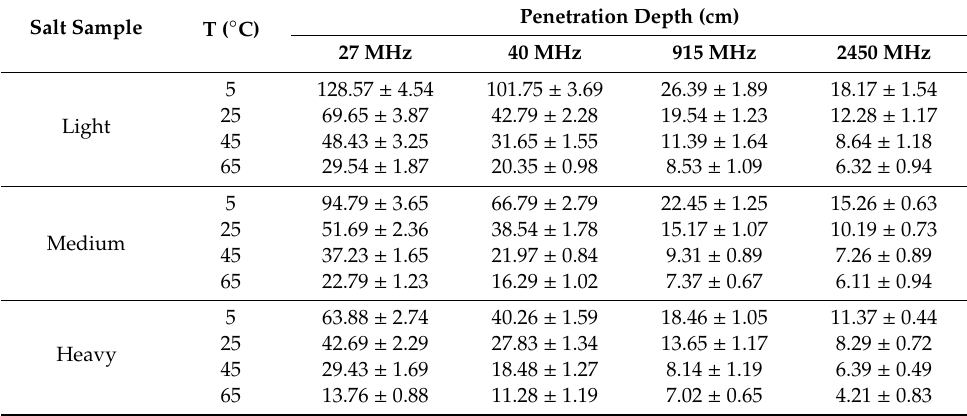
Table 9. Electromagnetic energy penetration depth for pecan nuts with di ff erent salt